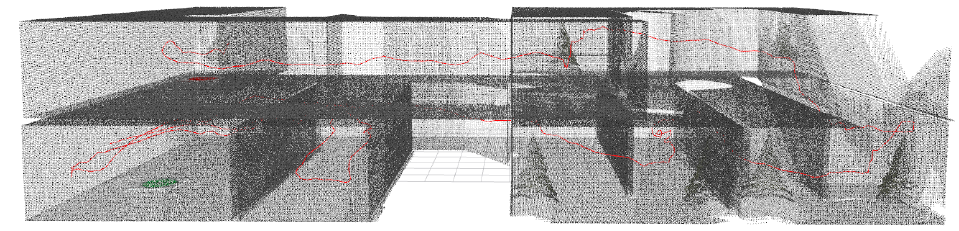
Figure 32. This figure illustrates the trajectory of the UAV from the starting location to the target location in the unknown environment (side view).